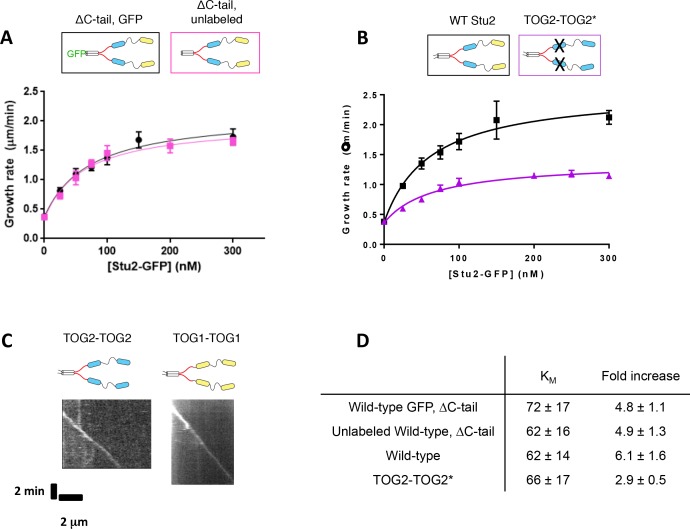
Additional data supporting the activity of various Stu2 constructs.(A) A Stu2-eGFP variant lacking the C-terminal tail (ΔC-tail) exhibits similar polymerase activity with (black) or without (pink) a C-terminal eGFP tag. Smooth curves indicate a hyperbolic fit to the data. Black: N = 45 measured from three different chambers, pink: N = 25. Error bars show SEM. (B) Mutating the basic-proximal TOG2 in an all TOG2 polymerase (TOG2-TOG2*, purple) results in a slight decrease in polymerase activity. Black: N = 45 measured from three different chambers; purple: N = 20 measurements. Error bars show SEM. Smooth curves indicate a hyperbolic fit to the data. (C) Both TOG2-TOG2 polymerases (kymograph, left) and TOG1-TOG1 polymerases (kymograph, right) can tip-track growing microtubule ends. Representative kymographs for each sample contain 100 nM Stu2 mutant and 800 nM wild-type yeast tubulin. (D) Summary statistics of hyperbolic fits to the activity measurements shown in A and B.10.7554/eLife.34574.005Figure 1—figure supplement 1—source data 1.Numerical data associated with Figure 1—figure supplement 1.